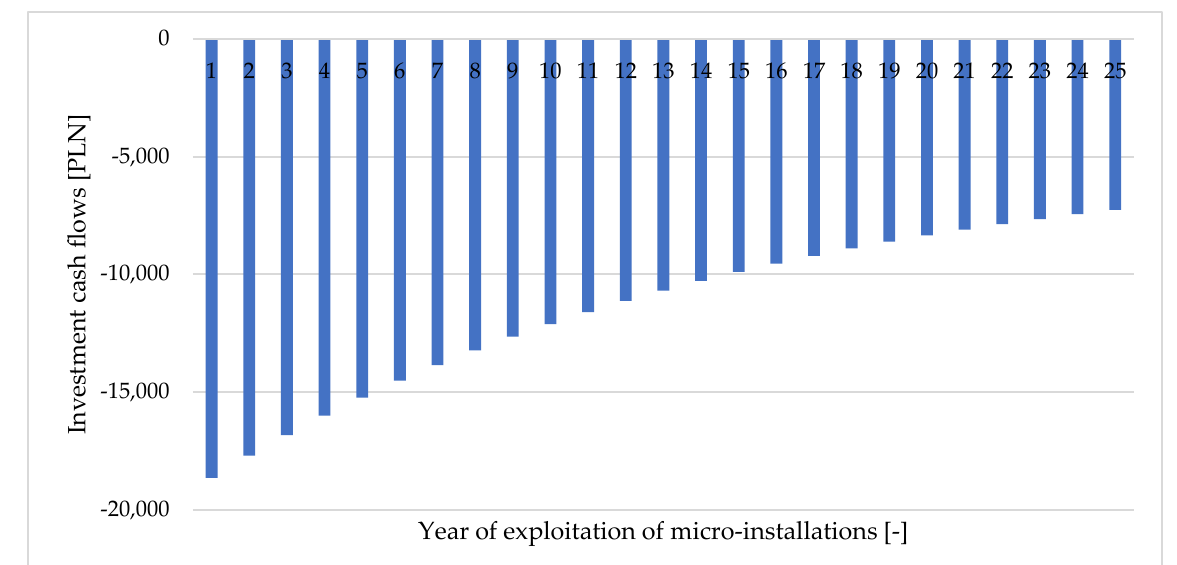
Figure 7. Graph showing the cash flow of the investment as a function of time of its operation for the net-billing system based on hourly prices and a 30% self-consumption level.